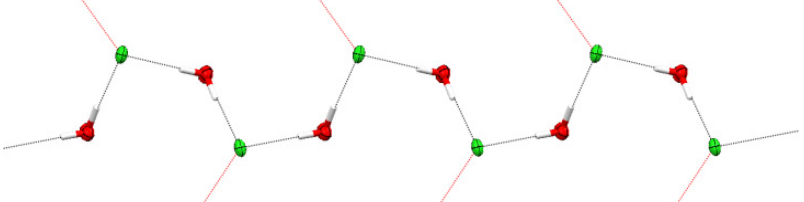
Figure 6. Thermal ellipsoid (50%) plot of the 1D polymeric chain formed by the {[Cl(H O)] − } cluster in the structure of III . 2 n